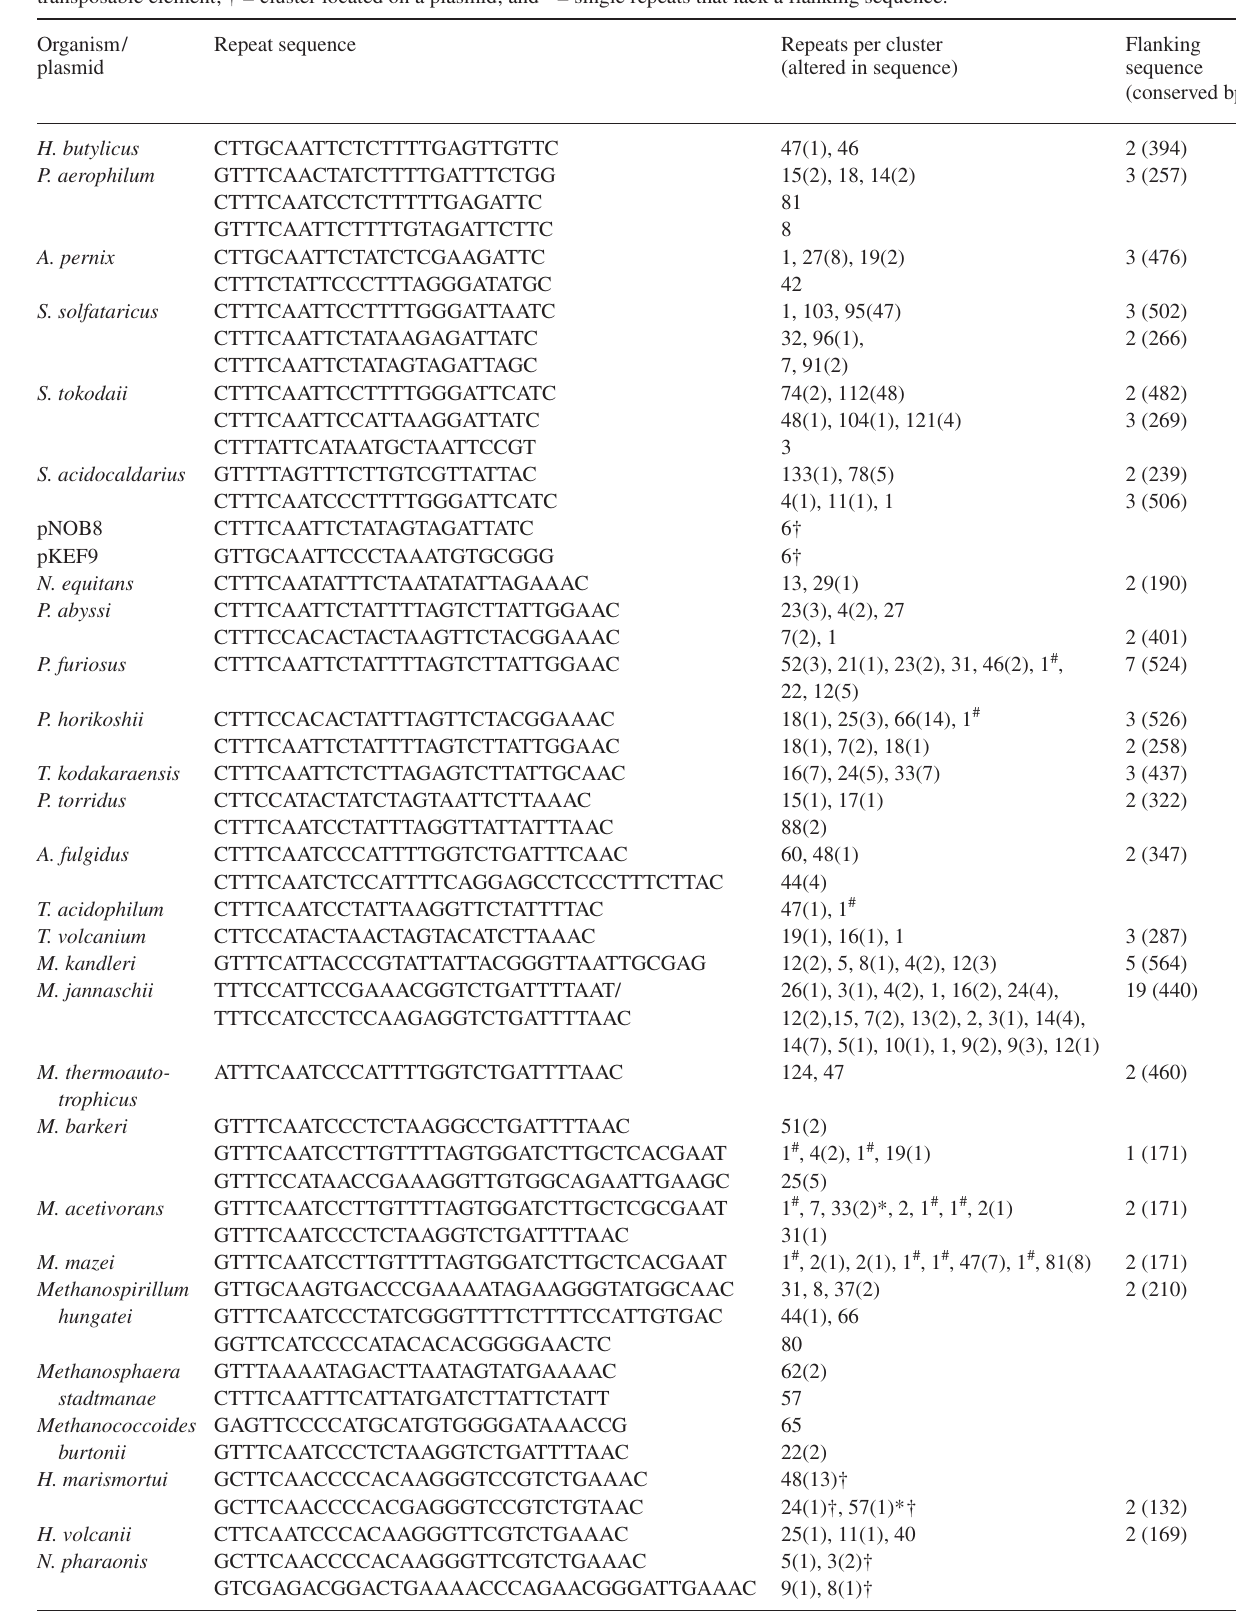
Table 2. Properties of the repeat clusters. Organisms are arranged in the same order as in Table 1. Symbols: * = cluster containing an inserted transposable element; † = cluster located on a plasmid; and # = single repeats that lack a flanking sequence.